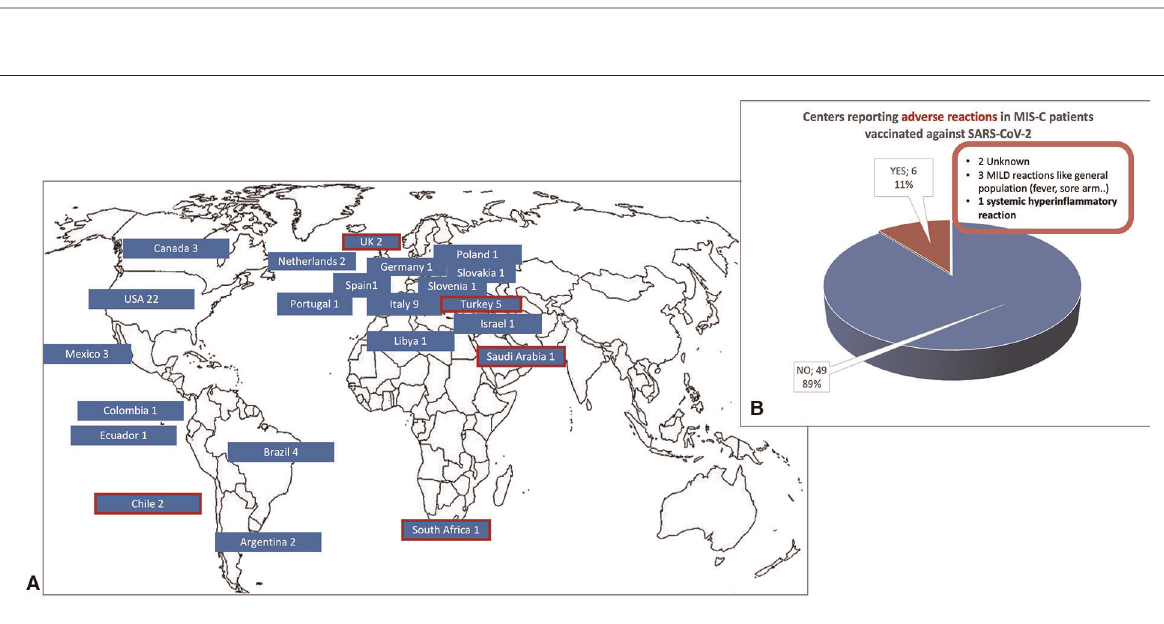
FIGURE 2 ( A ) The 67 centers from 22 countries that had already vaccinated patients with a history of MIS-C against SARS-CoV-2 and ( B ) reported adverse events*. In ( A ) the 5 countries in which 6 centers reported adverse events are circled in red. (*data available from 55